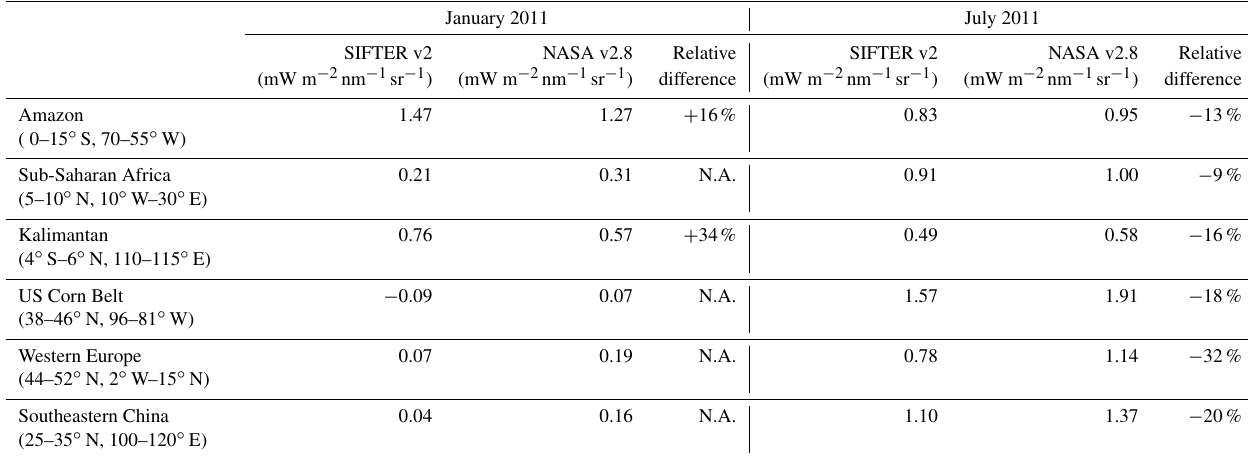
Table 5. Monthly mean gridded SIF values retrieved from GOME-2A with SIFTER v2 and NASA v2.8 for different vegetated regions throughout the world in January and July